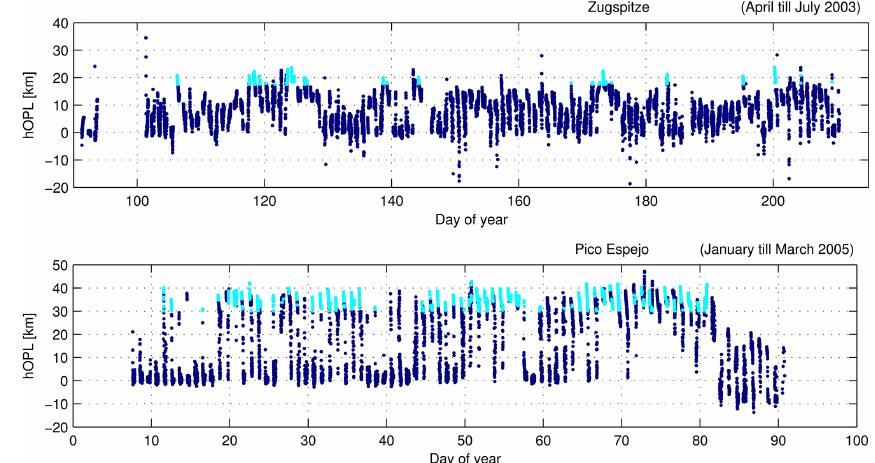
Figure 7. Time series of hOPL before (blue) and after (cyan) applying the filter criteria as defined in Sect. 6.2. Here, hOPL is obtained in the 346–372nm fitting window and shown for the period April–July 2003 at Zugspitze (upper panel) and for an exemplary dry season (January–March 2005) at Pico Espejo (lower panel).